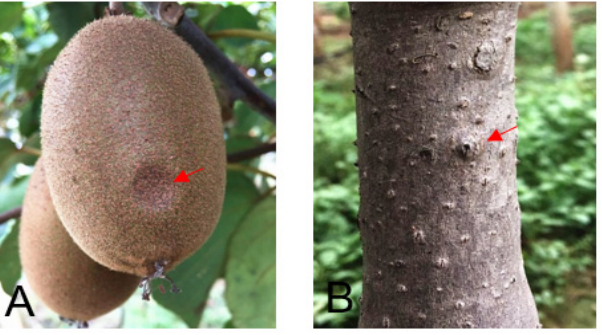
Figure 1. Symptoms of kiwifruit soft rot. ( A ) External slightly sunken symptom (arrow) on kiwi fruit. ( B ) Wart (arrow) on kiwi stem.